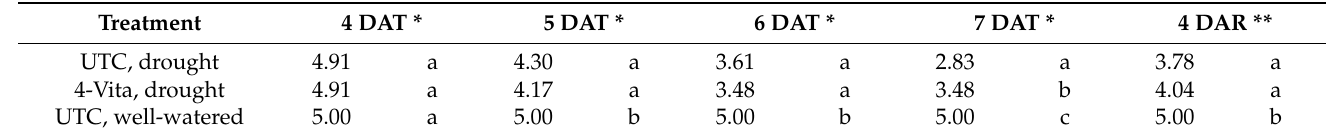
Table 2. Visual assessment of the wilting (scale going from 1 to 5, with 1 showing a plant completely wilted and 5 a plant in good health). For each trait, at least one letter in common indicates no significant difference.